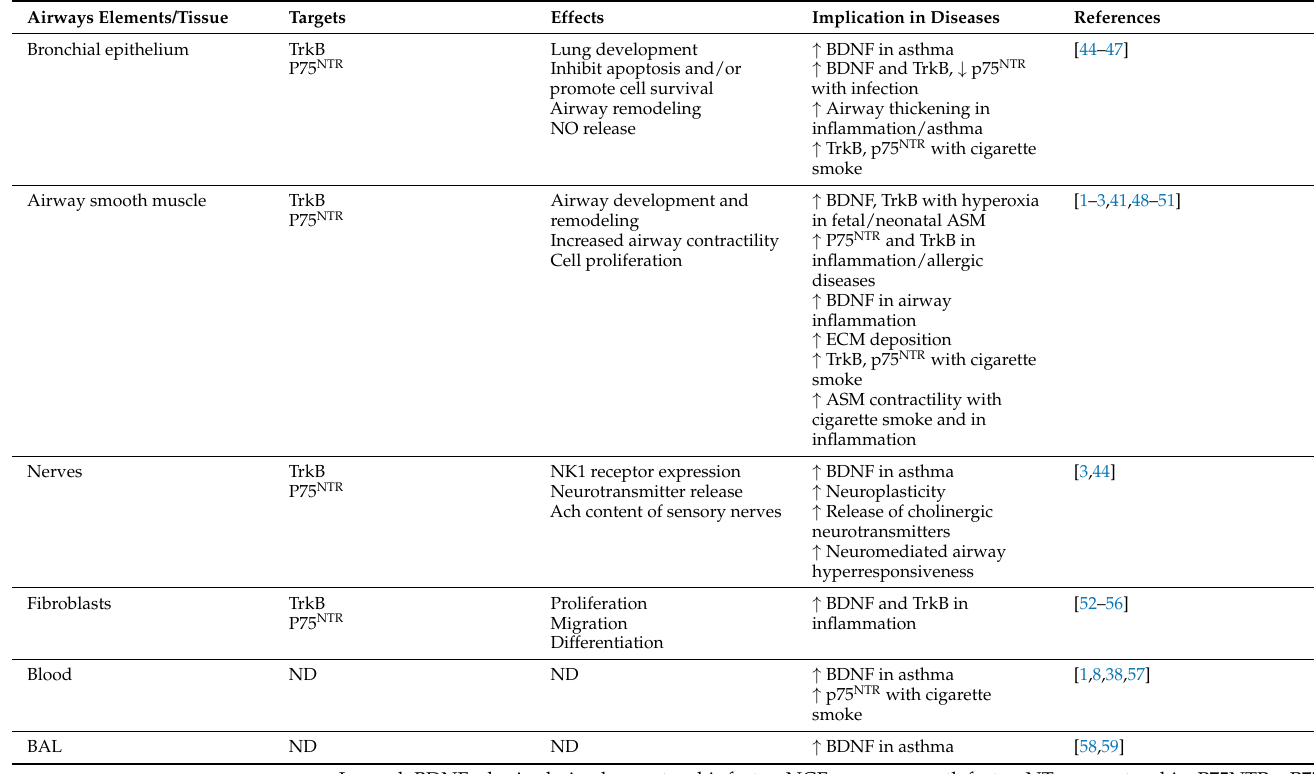
Table 2. Neurotrophin targets, effects, and implications in airway